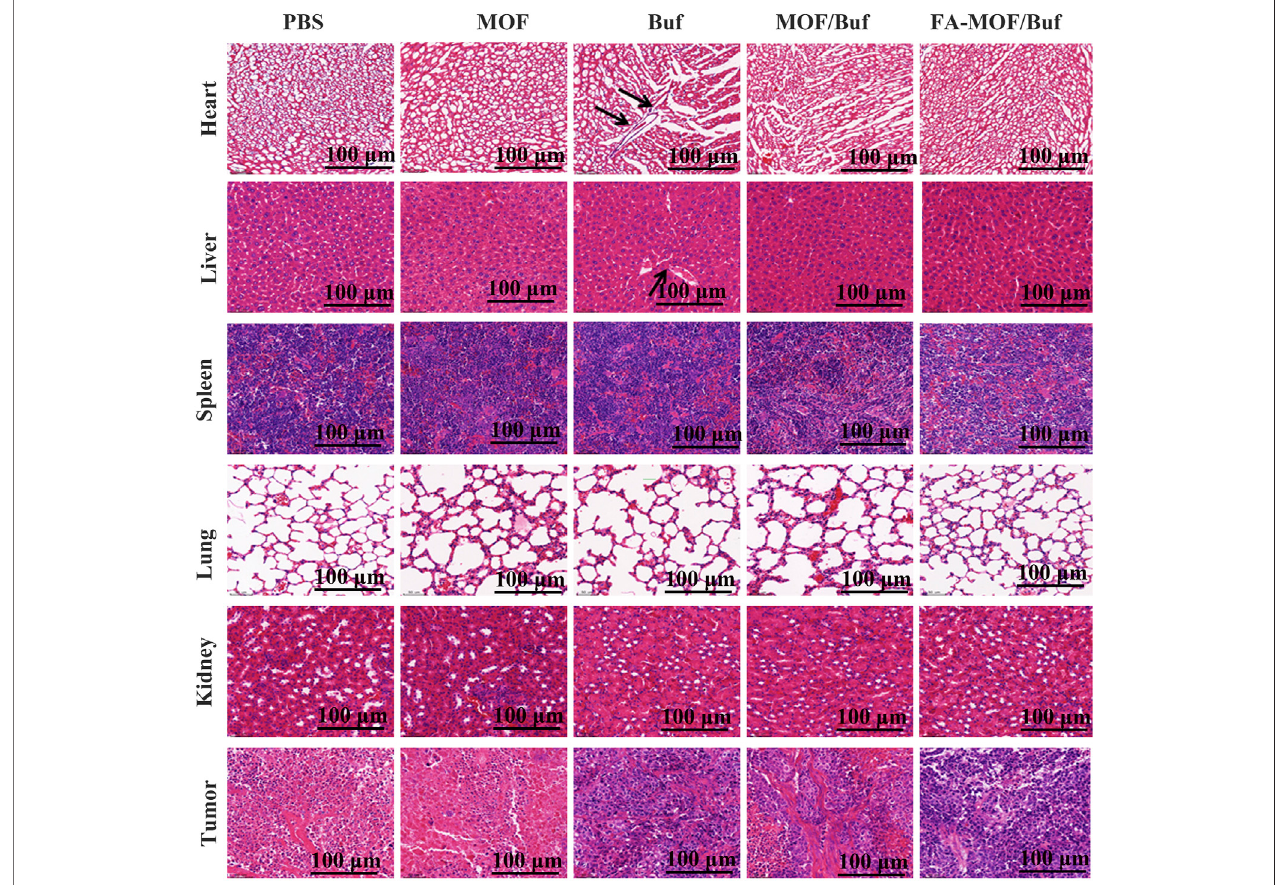
FIGURE 6 | Histopathological examination of major organs (heart, liver, spleen, lungs, and kidneys) and tumor tissues after treatment on the xenografted mice (scale bar: 100 μ m).